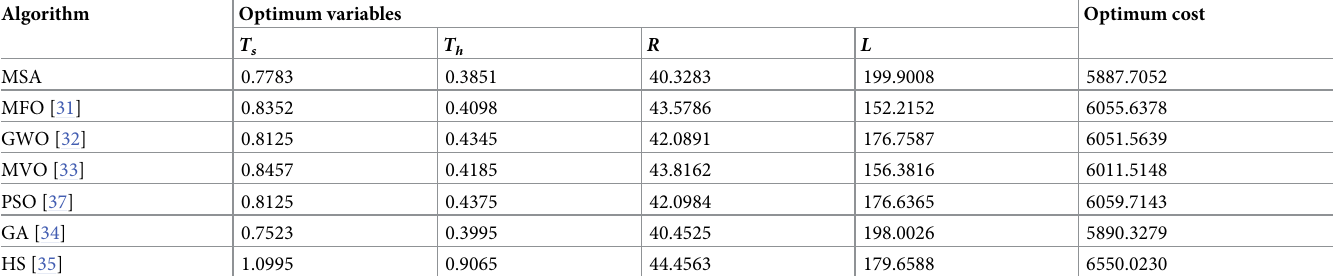
Table 10. Comparison results of pressure